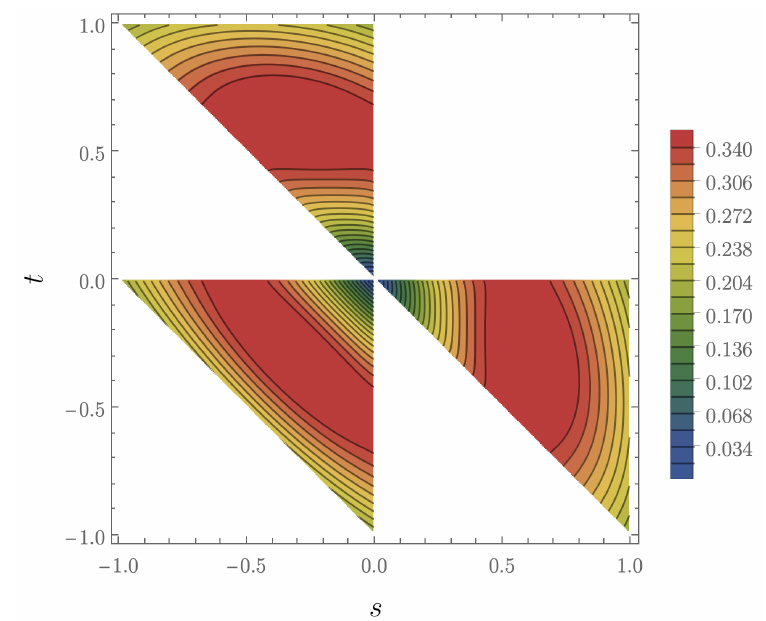
( s − 1 ) 2 ( t − 1 ) 2 ( u − 1 ) 2 in order to remove π 4